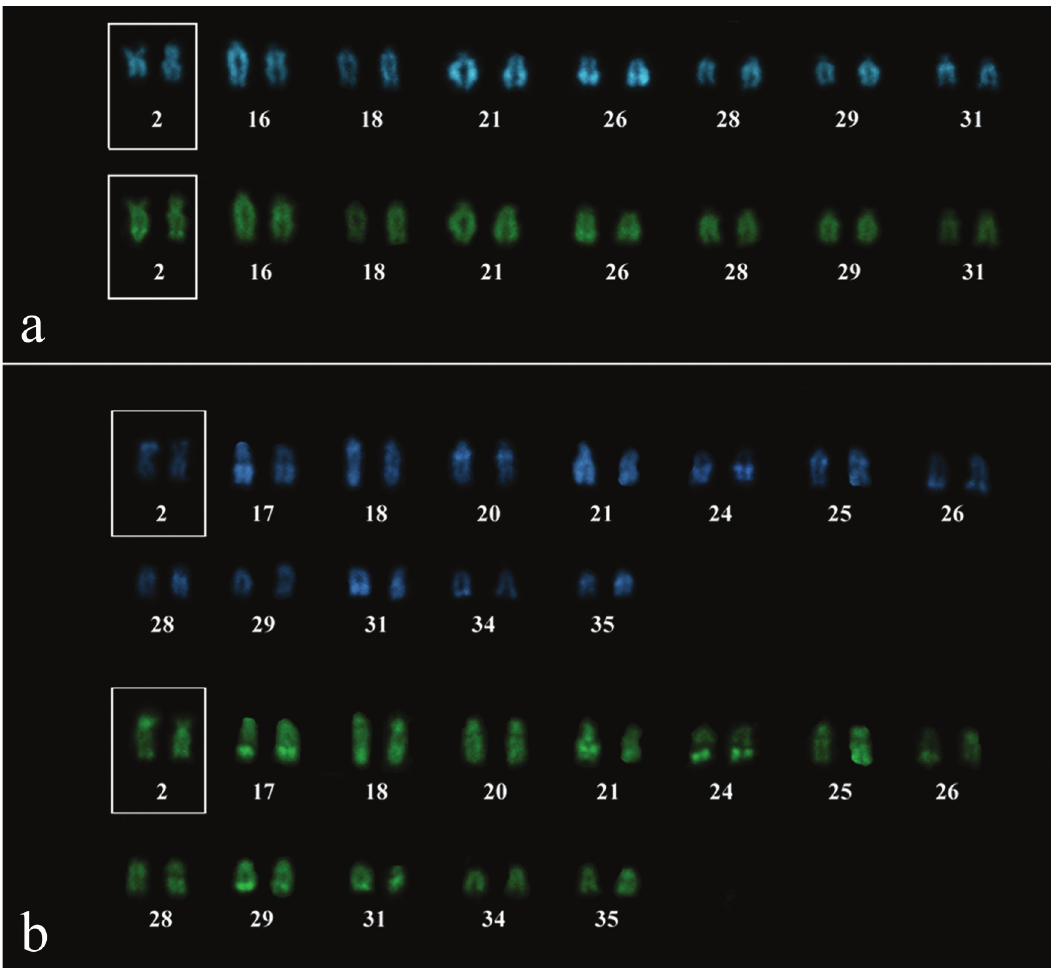
Fig. 4. DAPI and CMA stained chromosomal pairs from Mutum ( a ) and Una ( b ) Rivers, showing AT and GC-rich sites, 3 respectively. The NOR-bearing pair is